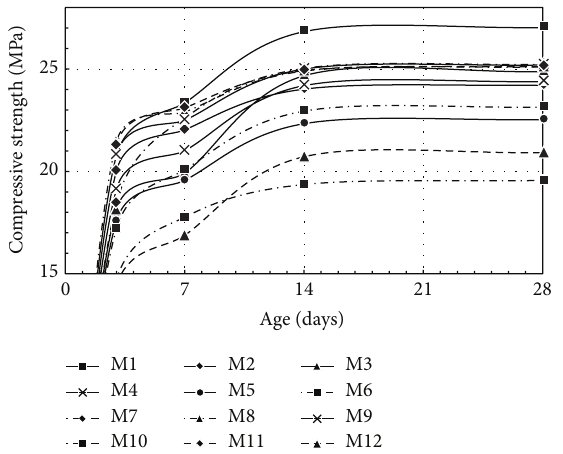
Figure 13: Compressive strength (MPa) versus age (days).